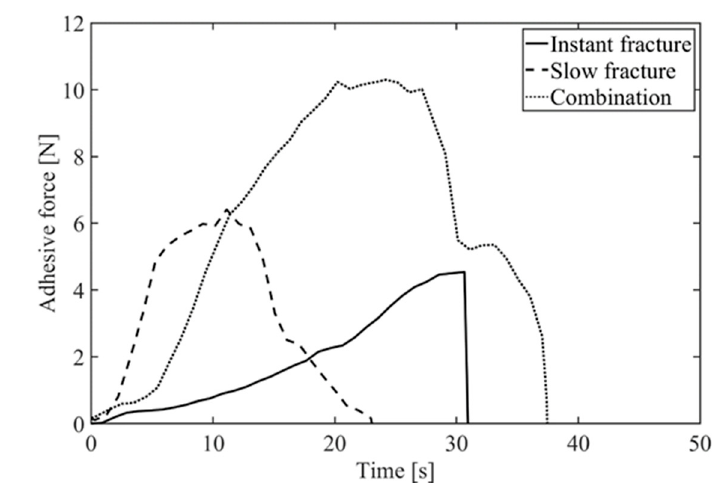
Figure 8. Force time histories of the adhesive force prior to pull-off as examples of classification of failure of mussel attachment.